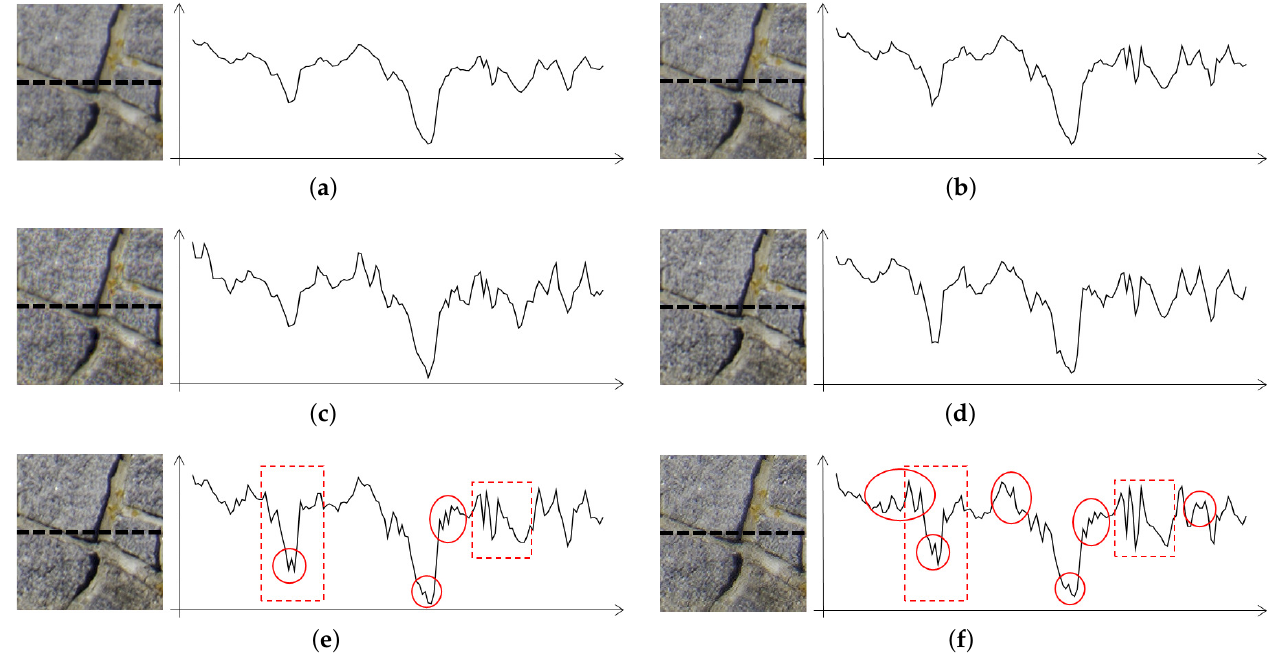
Figure 8. Comparison of enhanced detail image signal. ( a ) Original detail signal. ( b ) By the Unsharp masking method. ( c ) By the CAIDE method. ( d ) By the MESM method. ( e ) By the CWM method. ( f ) By the proposed